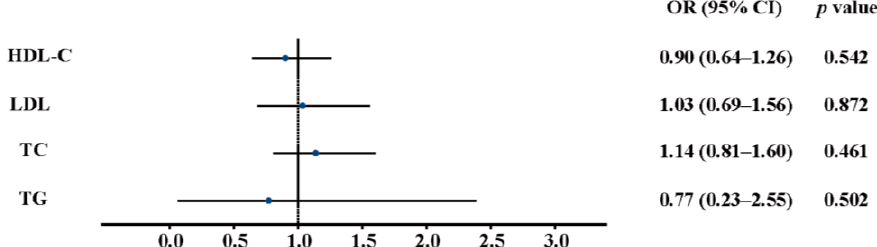
Figure 3. Associations between the genetically predicted plasma level of LDL-C, TC, TG and HDL- C and the risk of AD. LDL-C, low-density lipoprotein cholesterol; TC, total cholesterol; TG, triglyc- eride; HDL-C, high-density lipoprotein cholesterol; CI, confidence interval; OR, odds